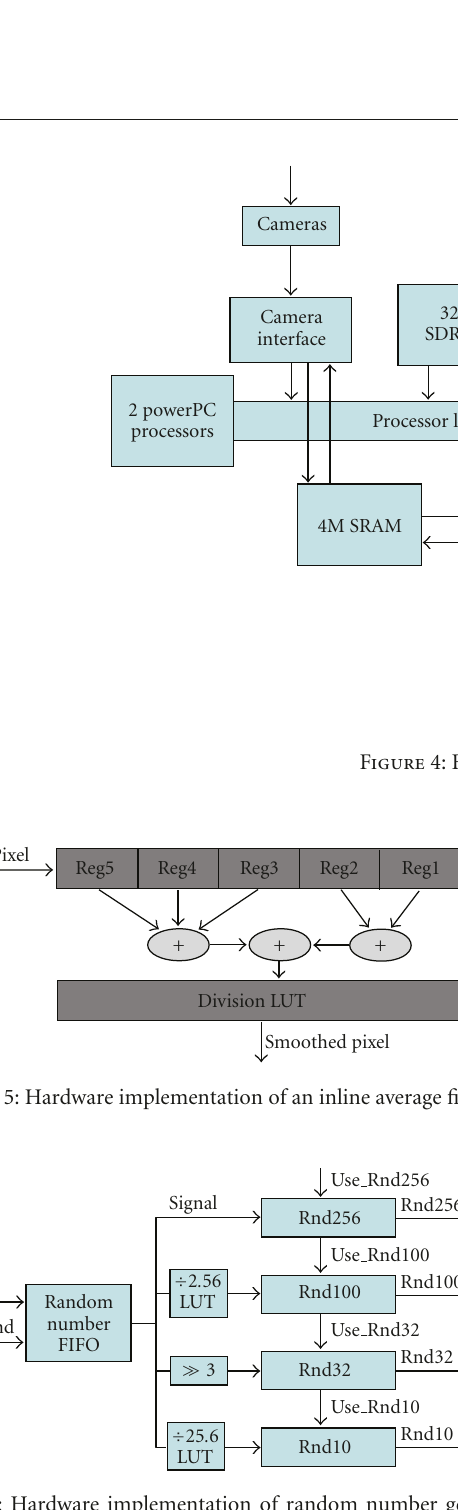
Figure 6: Hardware implementation of random number genera-